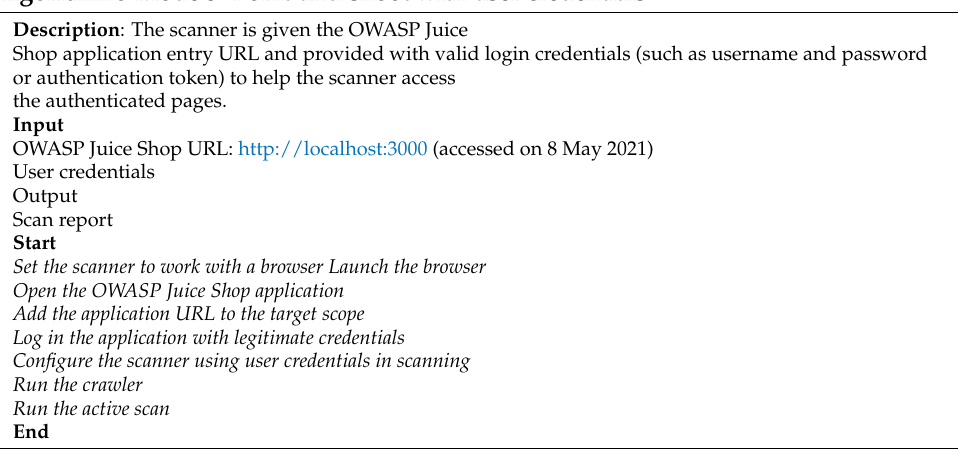
Algorithm 3 Mode 3: Point-and-shoot with user credentials